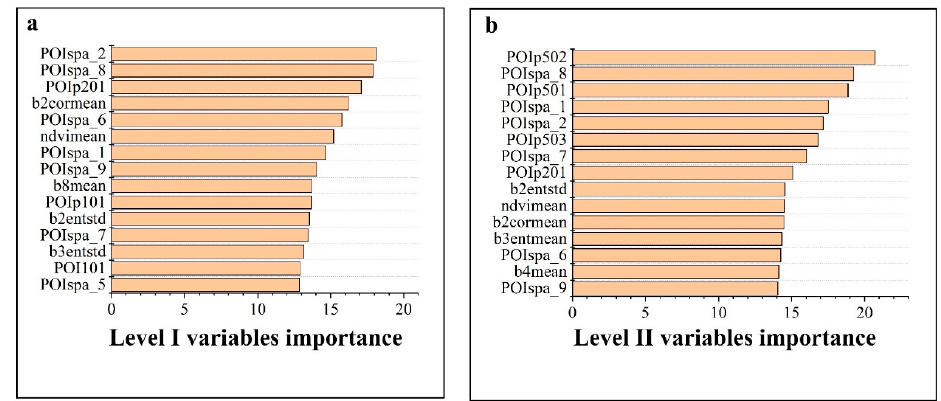
Figure 9. ( a ) The feature importance rank in the Level I classification framework. ( b ) The feature importance rank in the Level II classification framework.